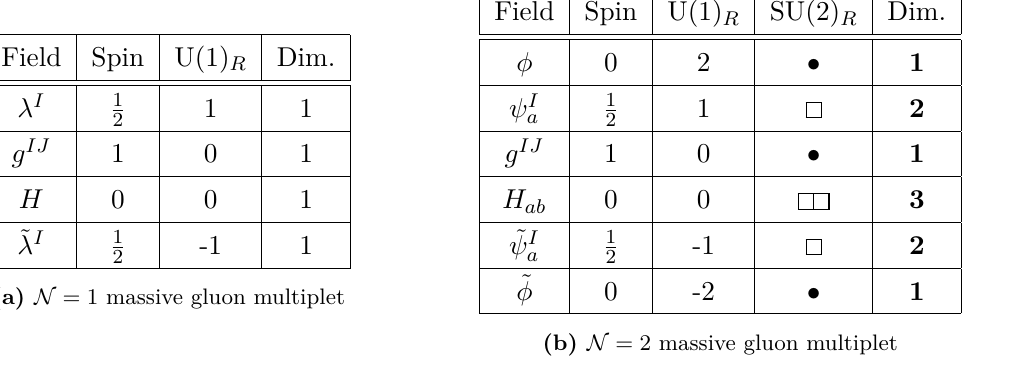
Table 4. On-shell content of massive gluon multiplets with N ≤ 2 supersymmetry. States are labelled with capital Latin indices I, J, . . . corresponding to SU(2) LG and lowercase Latin indices a, b, . . . corresponding to SU( N ) R . The last and second-to-last columns gives the dimension and Young tableaux respectively of the SU( N ) R representations in the conventions of [62,